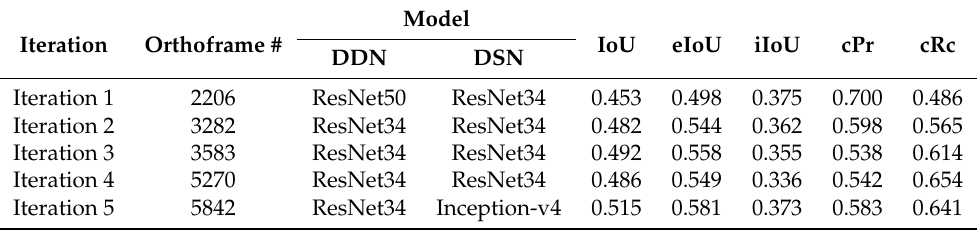
Table 3. Defect segmentation performances computed over the test set. Iterations with their respective number of training and validation orthoframes are